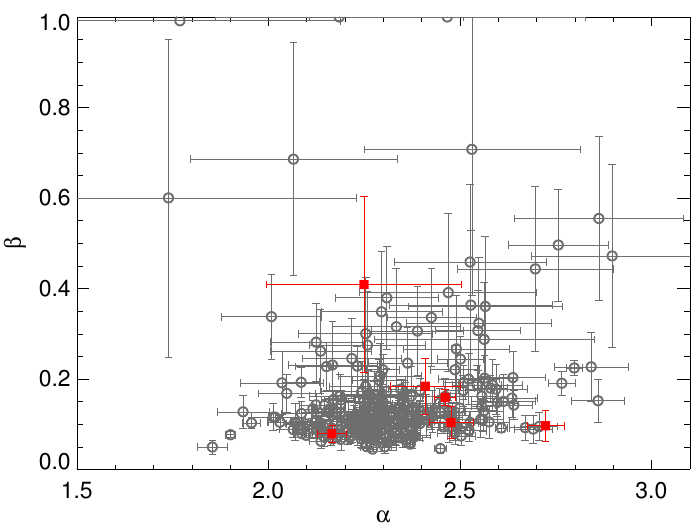
Figure 1. Scatter-plot of the two spectral parameters ( α and β ) for the different object categories. Open gray circles represent flat-spectrum radio quasars, while filled red squares represent narrow-line Seyfert 1 galaxies, respectively. Data and errors from the